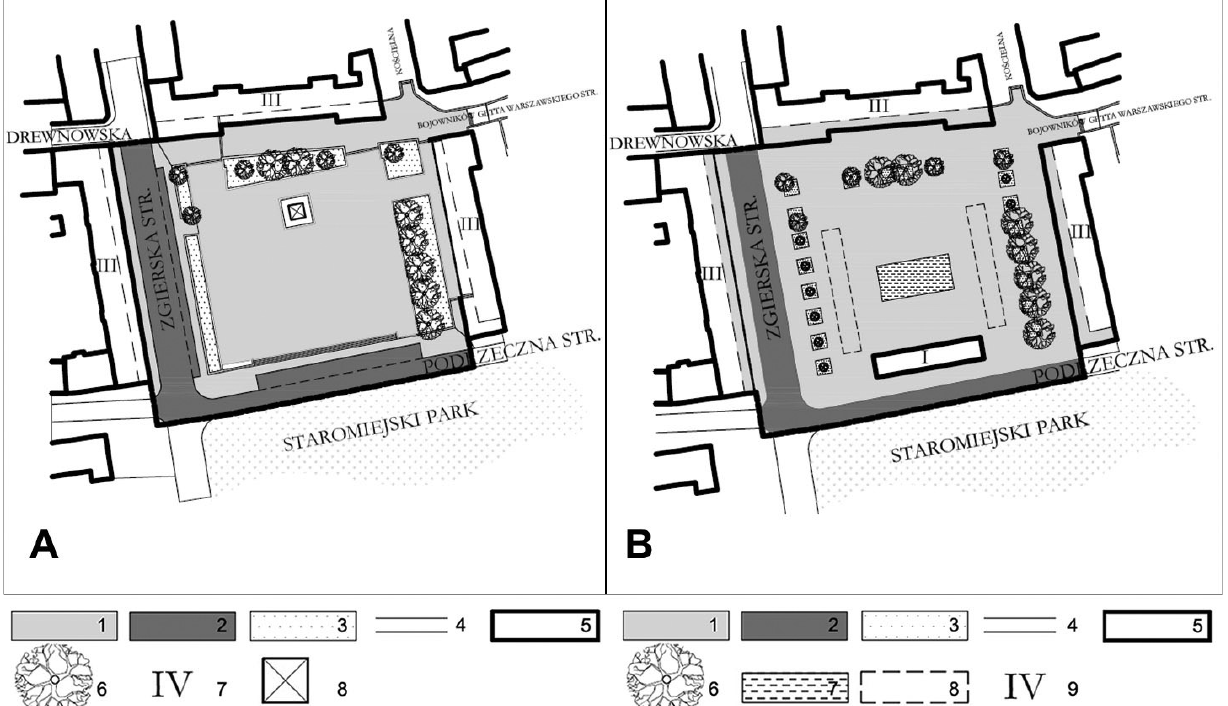
Figure 3. Old Market Square, Lodz. A) 1956–2021. Legend: 1. Pavement, 2. Roadways, 3. Lawns, 4. Trees, 5. Buildings, 6. Tramway tracks, 7. Number of floors, 8. Monument of Julian Marchlewski (1964–1989); B) Concept design of 2016 planned redevelopment, designed by Jakub Krzysztofik, Sylwia Krzysztofik, and Michał Domińczak. Legend: 1. Pavement, 2. Roadways, 3. Lawns, 4. Trees, 5. Buildings and new pavilion, 6. Tramway tracks, 7. Number of floors, 8. Light